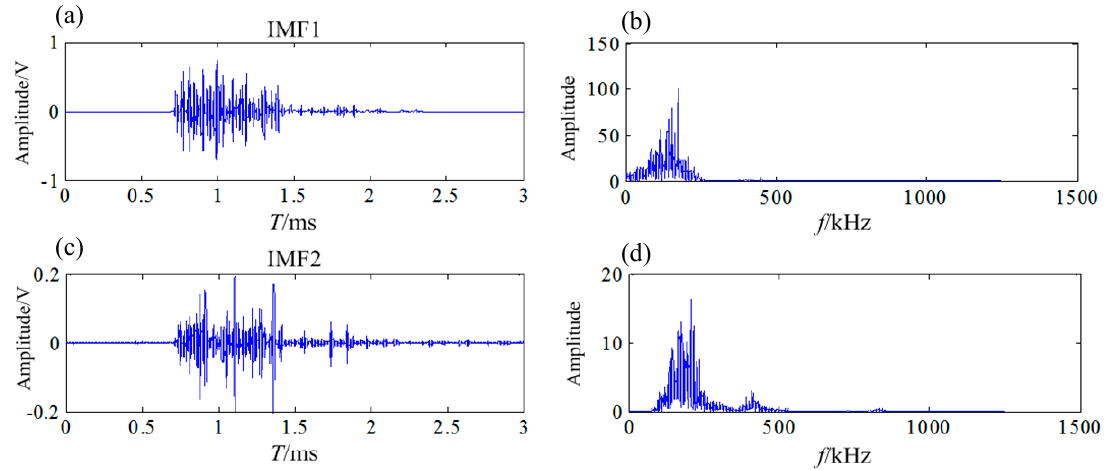
Figure 14. The waveform and spectrum of IMF after denoising ( a ),( c ) the waveform; ( b ),( d ) the frequency spectrum.